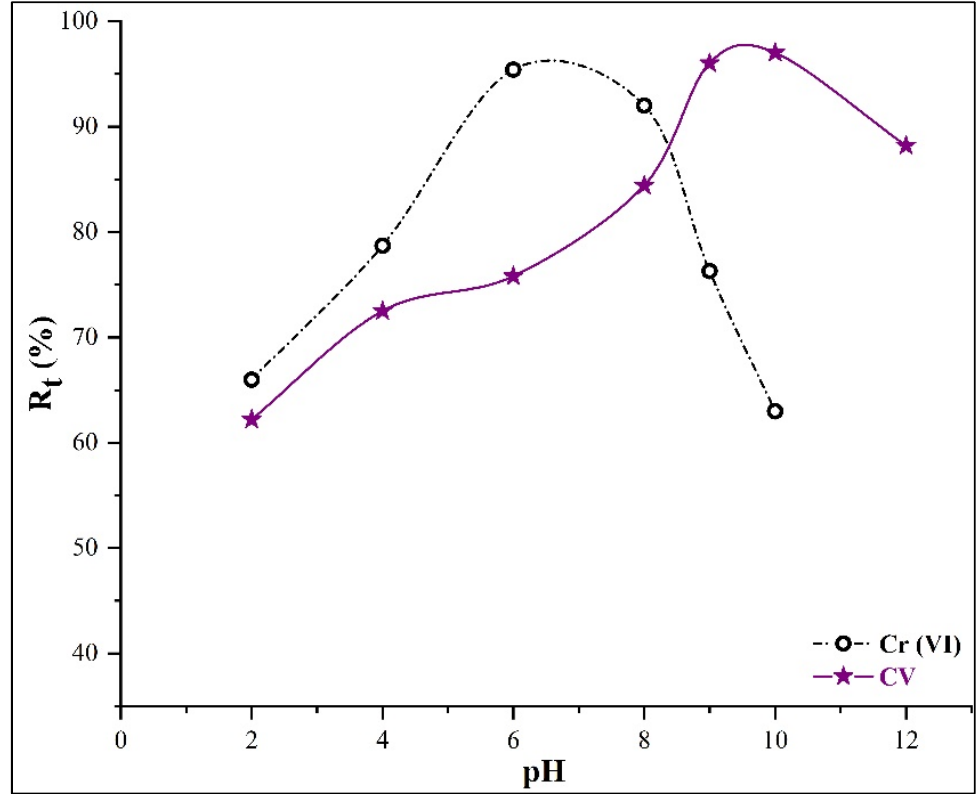
Figure 8. pH effect on the adsorption of Cr (VI) and CV by ACSCGs.